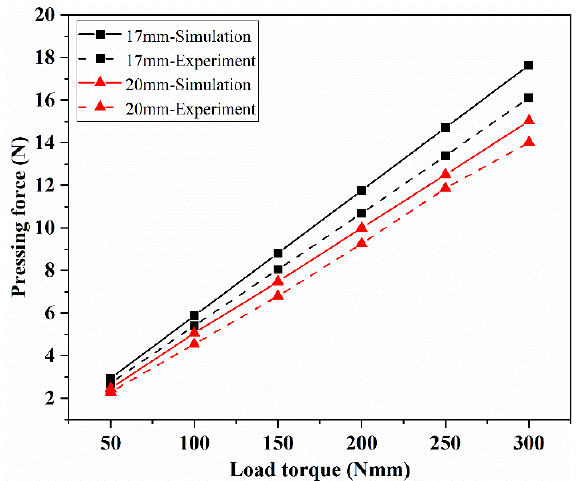
Figure 24. The influence of distribution radius on the pressing force.